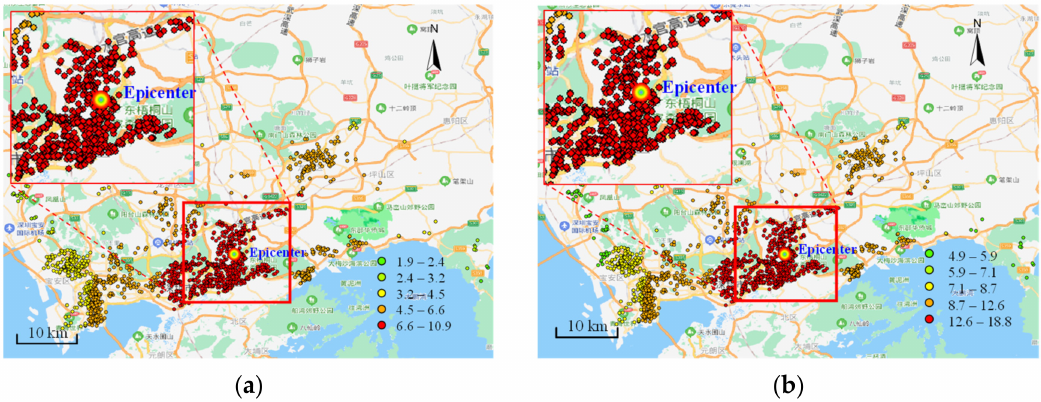
Figure 17. Distribution of ground motion intensity measure Sa (0.3s) (m/s 2 ): ( a ) M6.5; ( b )